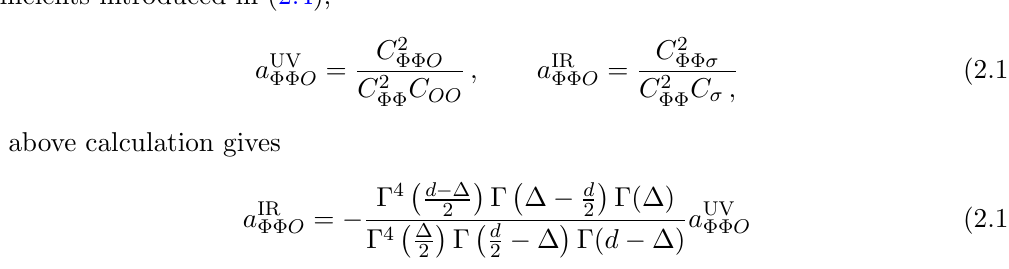
. Using the normalized squared (cid:8)(cid:8) (cid:27)